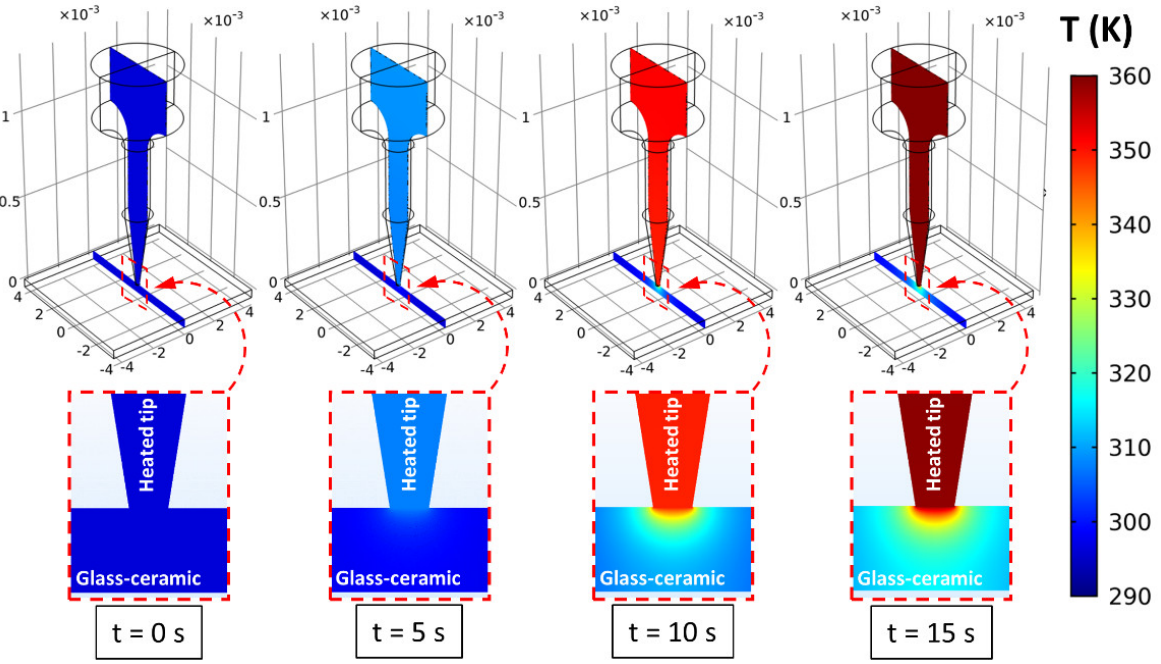
Figure 6. Simulated two-dimensional temperature distributions of the measuring system at differ- ent time points. time